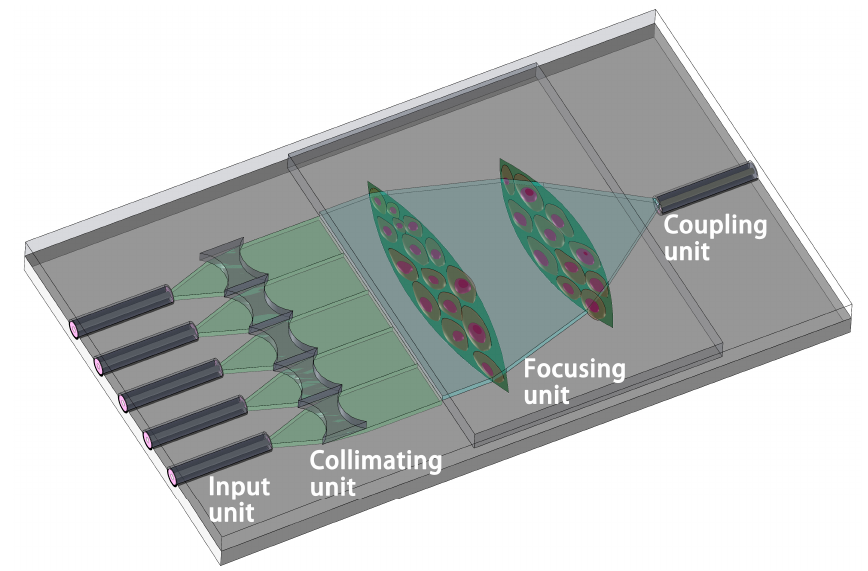
Figure 1. System schematic graph of the cell density detector.